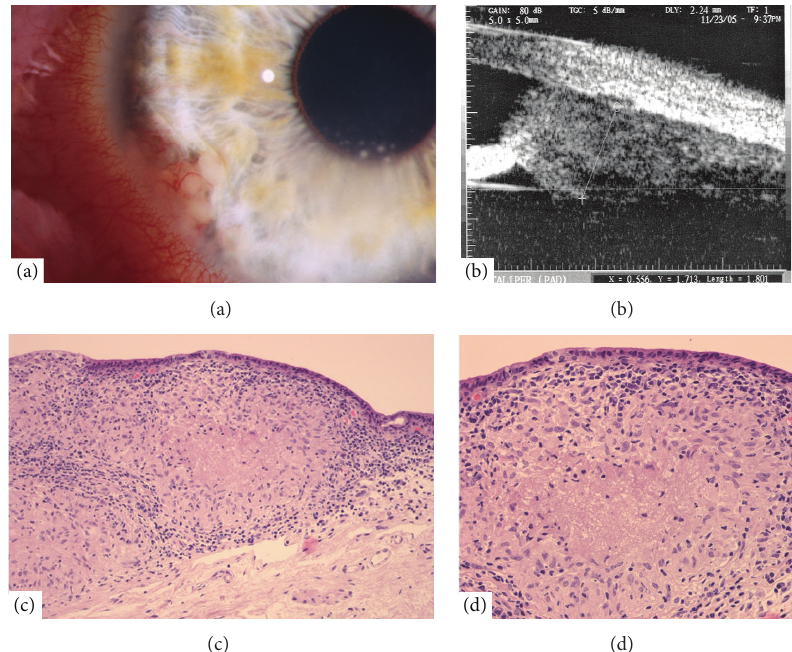
Figure 1: (a) Slit-lamp examination of prominent vascularized lesion of the iris and ciliary body with keratic precipitates. (b) Ultrasound biomicroscopy(UBM)imageoftheirisandciliarybodylesion.(candd)Conjunctivalbiopsyspecimenshowsepithelioidcellgranulomaswith central necrosis (periodic acid-Schiff